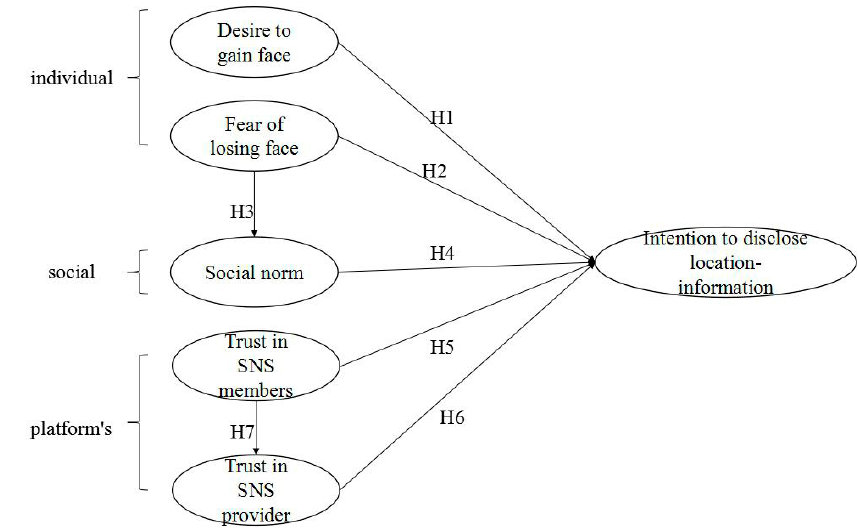
Figure 1. Research